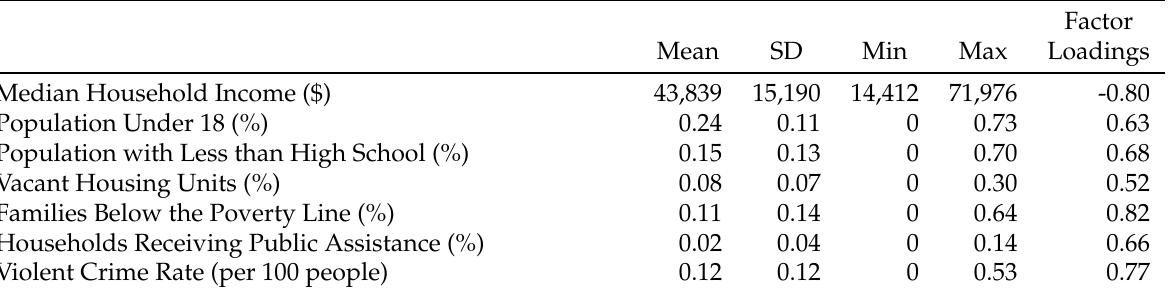
Table 1: Neighborhood Disadvantage Scale Factor Loading